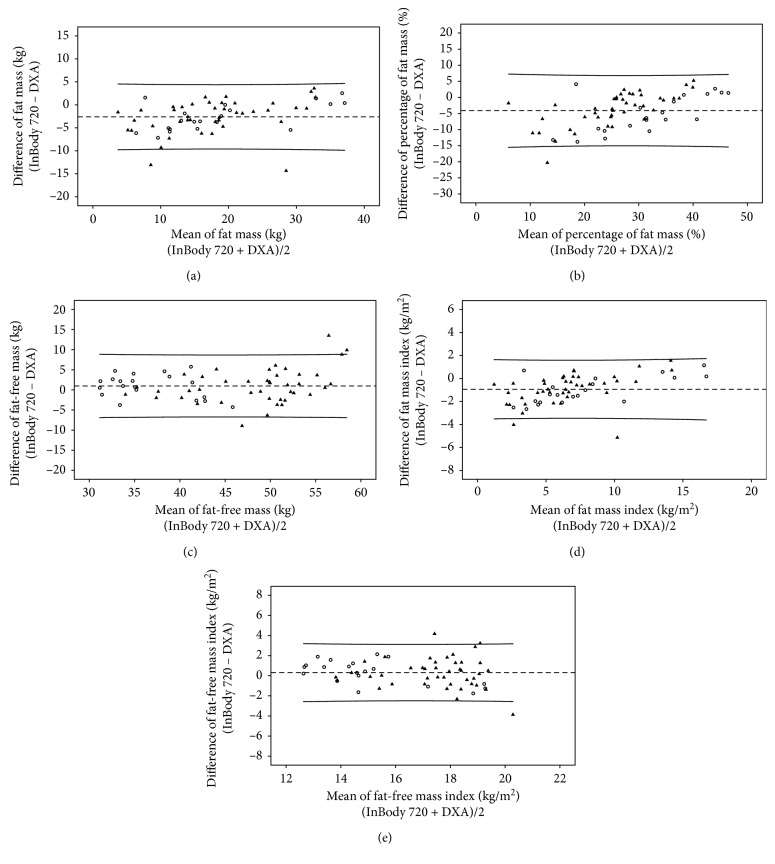
The agreement between DXA and BIA 720 in (a) fat mass, (b) percentage of fat mass, (c) fat-free mass, (d) fat mass index, and (e) fat-free mass index. Black filled-in triangles represent values of male, and black circles represent values of female.